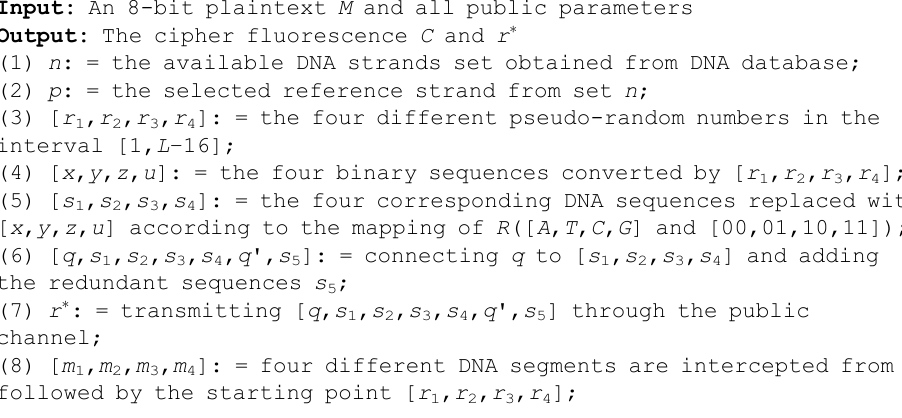
Algorithm 1. The encryption algorithm based on the DNA self- assembly structure